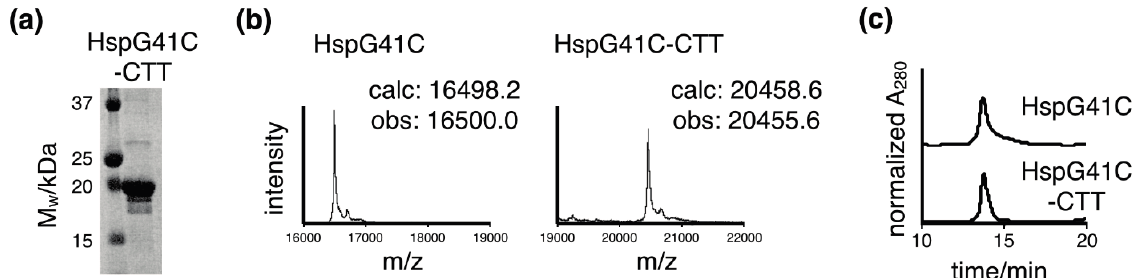
Figure 2. Purification of protein nanocages. ( a ) SDS-PAGE analysis of the recombinant subunits of the nanocages; ( b ) MALDI-ToF mass spectra analysis of the dissociated subunits of HspG41C and HspG41C-CTT. The observed molecular masses are shown; ( c ) Size exclusion chromatography of HspG41C and HspG41C-CTT.